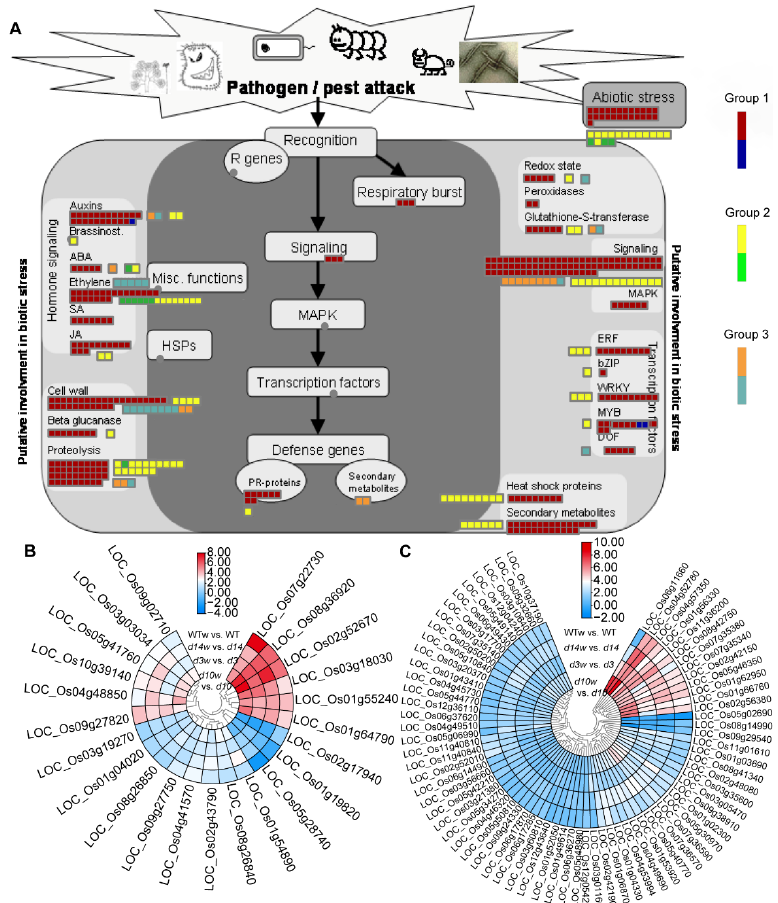
Figure 7. MapMan analysis based “biotic stress pathways” of DEGs in three groups. ( A ) The schematic diagram of biotic stress categories. The small heatmap in each section of the diagram shows the DEGs mapped to that pathway, and a small square indicates a transcript. Red, orange, and yellow indicate upregulated genes in each group; blue, light sea green, and green means downregulated genes in each group. ( B , C ) DEGs related to ethylene metabolism ( B ) and signaling pathway ( C ). Heatmaps of DEGs were drawn using the log 2 (FC) value obtained from the pairwise comparison of samples. Red and blue indicate upregulation and downregulation, respectively.